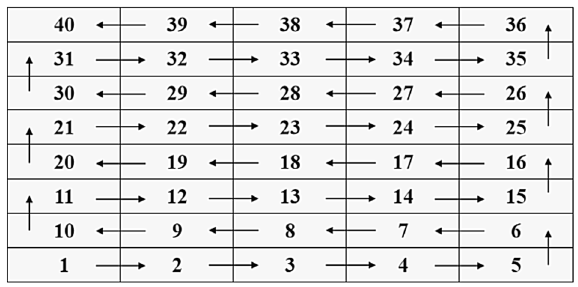
Figure 3. Scanning route.